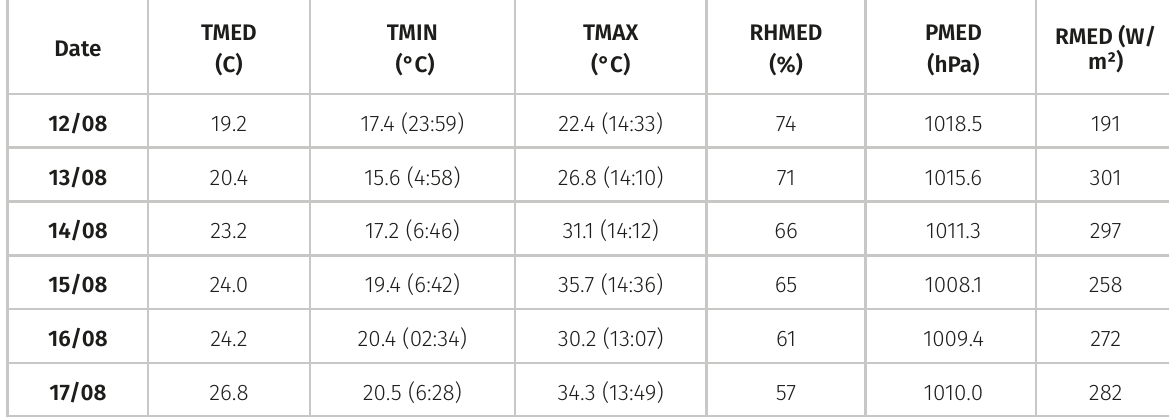
Table II. Daily mean meteorological parameters of the AWS at JHOS. TMED is mean air temperature. RHMED is mean relative humidity. PMED is mean atmospheric pressure. RMED is mean global radiation. TMIN and TMAX are daily air minimum and maximum temperatures, respectively. Local times of TMIN and TMAX are shown in